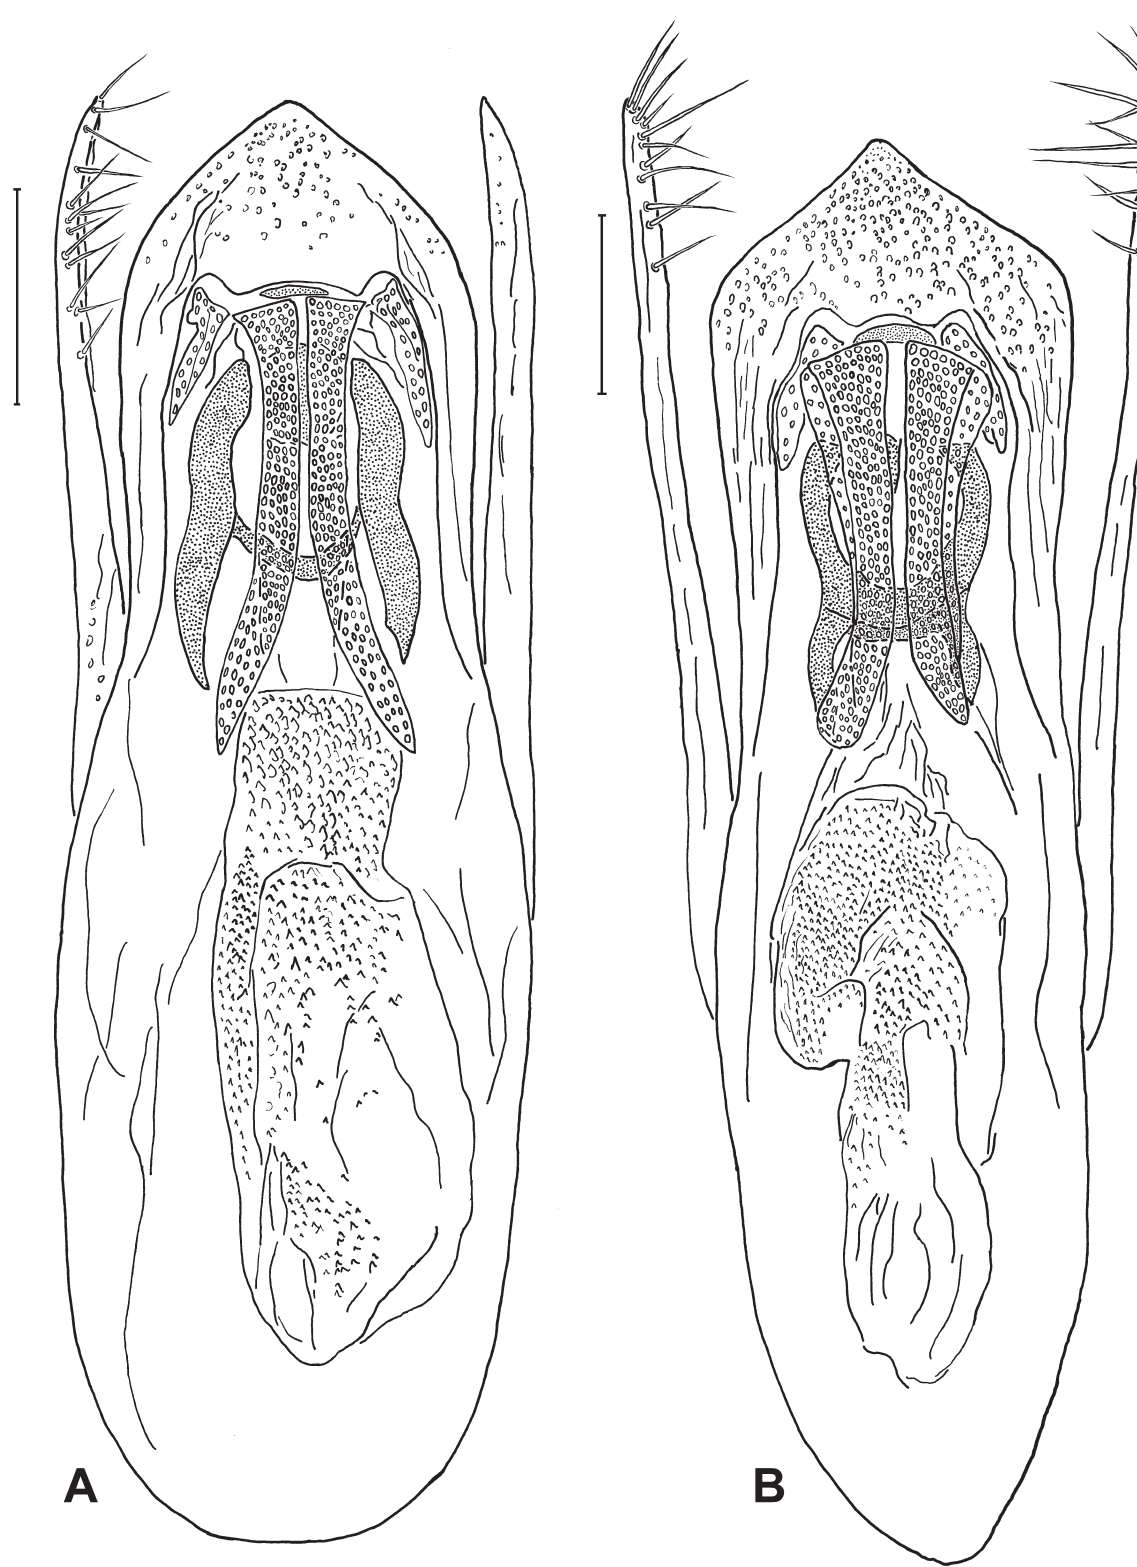
Fig. 6. Aedeagus, ventral view. A . Stenus ( Nestus ) delitor sp. nov. (holotype). B . S. ( N. ) sphaerops Casey, 1884 (U.S.A.: New york: Albany Co.). – Scales = 0.1